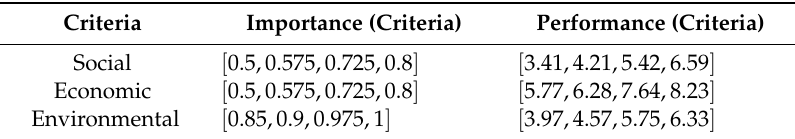
Table 8. The obtained performance rates for the criteria level.